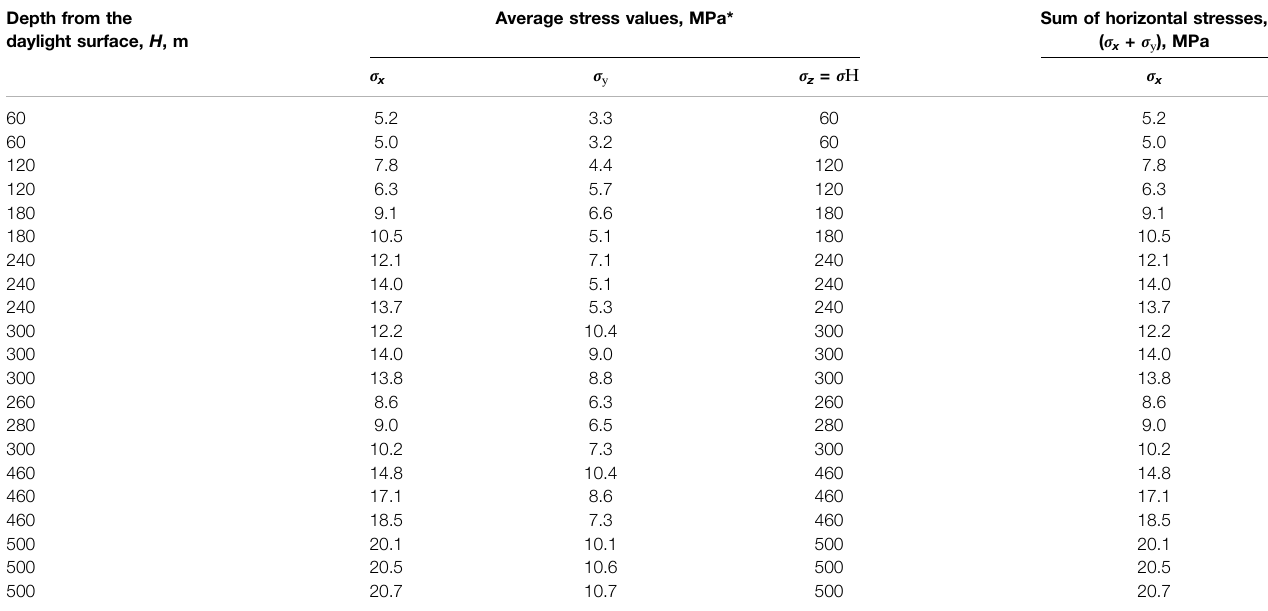
TABLE 2 | Results of measuring the natural stresses in the Saryoba deposit. Depth from the daylight surface, H , m